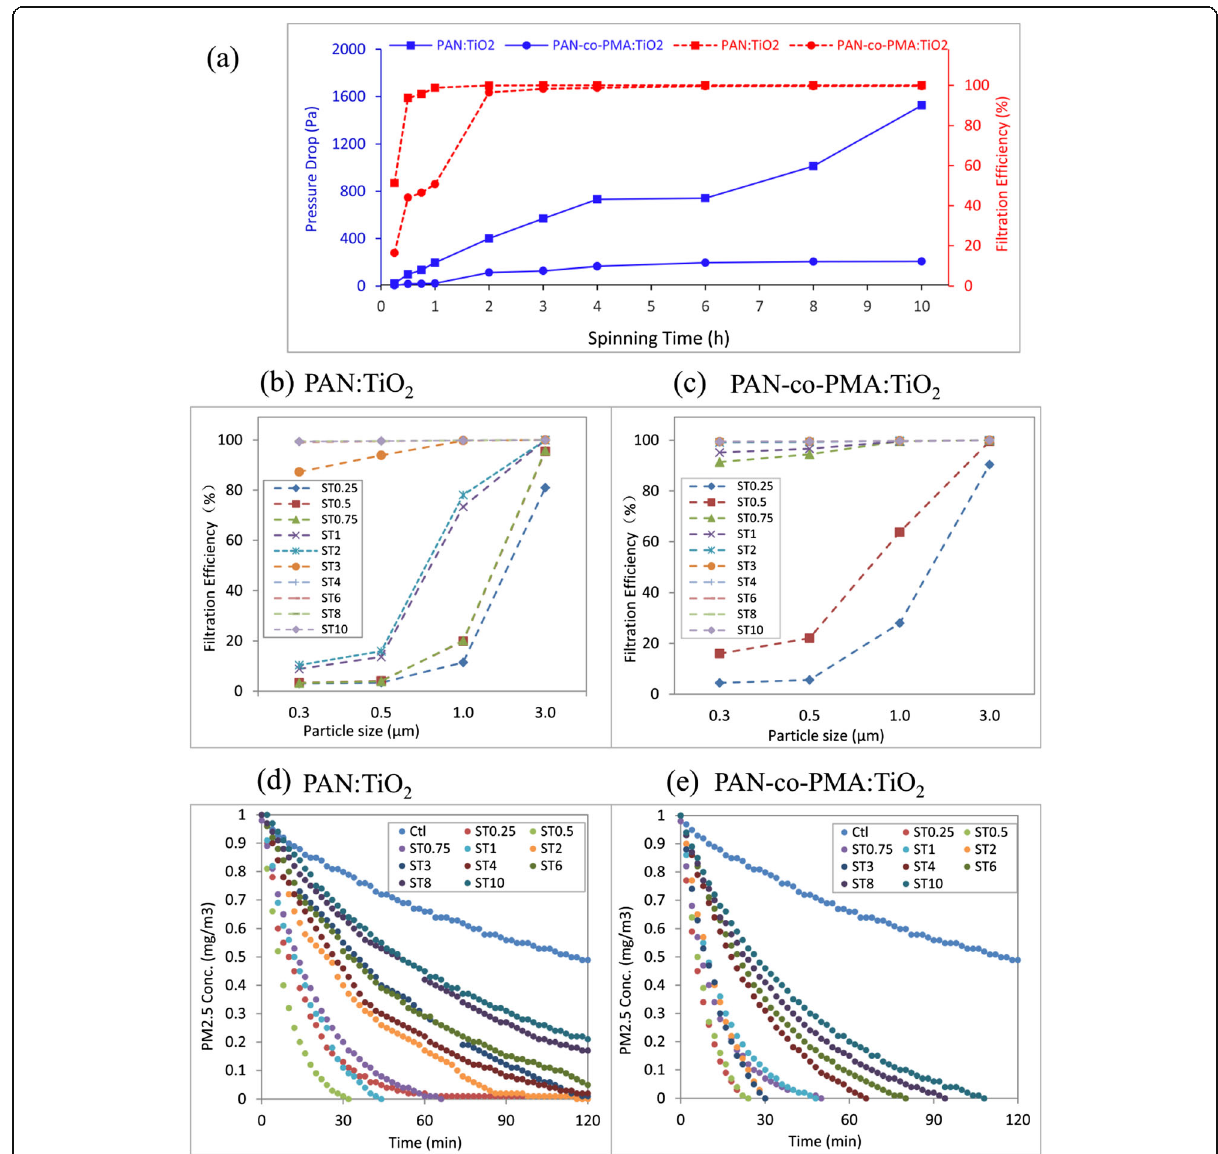
Fig. 4. PAN:TiO2 and PAN-co-PMA:TiO2 nanofiber membranes ’ filtration efficiency with ( a ) pressure drop of aerosols ( a ) and particle size ( b , c ); and the removal capability of ( d ) PAN:TiO2 and ( e ) PAN-co-PMA:TiO2 nanofiber membranein simulated polluted air